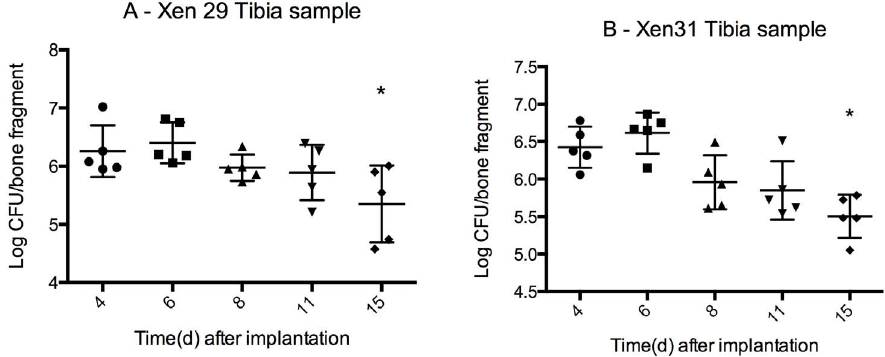
Figure 4. Bacterial load in infected tibia mean CFU 6 SD (logarithmic scale). Bacterial load from two different S. aureus strains, Xen 29(MSSA) and Xen 31(MRSA). The infection is a localized OM adjacent to the stainless steel pin implanted through the metaphysis of the bone. Bone fragment weight 0.08 g 6 0.01 g. Bacterial load by day 15 are significantly lower (marked with*) than initial load by day 4 for both X29 (P=0.04) and X31 (P=0.001). From day 8–15, the infection remains stable (no difference in mean) for both strains (one way ANOVA, P=0.14 for X29 and P=0.06 for X31). n=5 for each group.